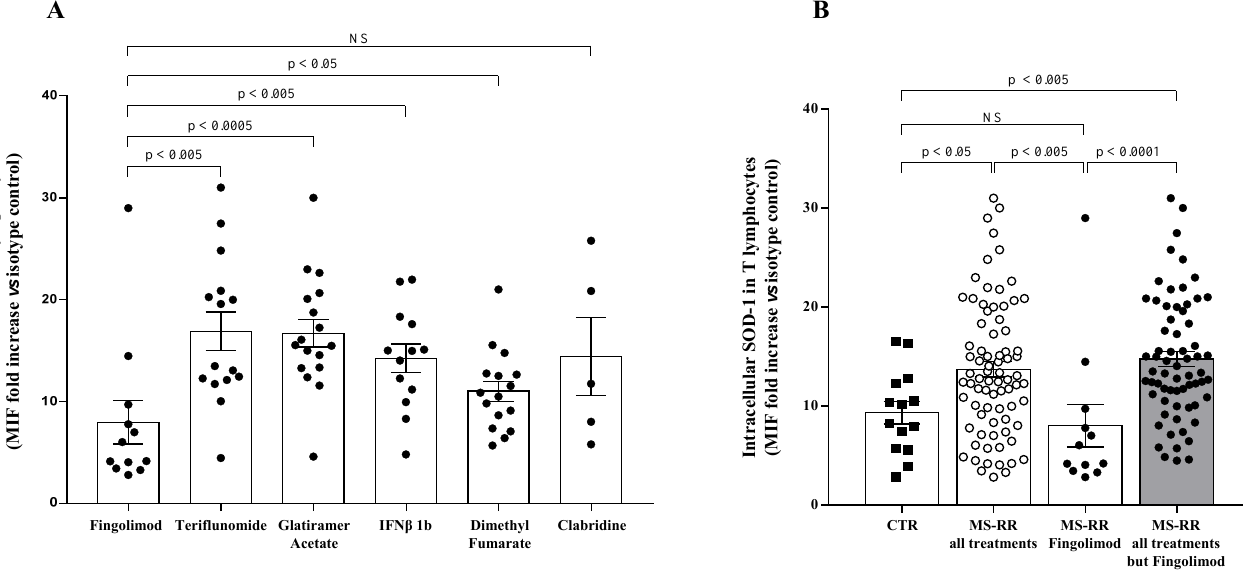
Figure 1. T cells from MS-RR individuals undergoing immune-modulating treatment, except fingolimod, showed significant increase of SOD-1 intracellular levels, as compared with healthy controls. ( A ) SOD-1 level in T lymphocytes obtained from MS-RR subjects undergoing different immune-modulating treatments. SOD-1 intracellular amount was expressed as the ratio of the mean intensity fluorescence (MIF) value for T-cell population and the control MIF value obtained after staining of the same cell subset with the isotype control mAb (see Patient and Method section). Each column refers data obtained in MS-RR subjects categorized according to the treatment they underwent. As shown, all treatments were able to increase SOD-1 levels in T lymphocytes, as compared with fingolimod. ( B ) Intracellular SOD-1 content in T lymphocytes of healthy controls ( n = 14; white column with black squares), MS-RR subjects as a whole ( n = 78; white column with white dots), MS-RR individuals undergoing fingolimod treatment ( n = 12; white column with black dots), and MS-RR individuals undergoing all treatments, except Fingolimod ( n = 64; grey column with black dots). As shown, when MS-RR individuals were grouped according to the treatment, significant SOD-1 increase in T cells only characterized the subjects undergoing all immune-modulating therapies, except fingolimod. Statistical evaluation of data was performed by means of the Mann–Whitney test. Statistically significant values are